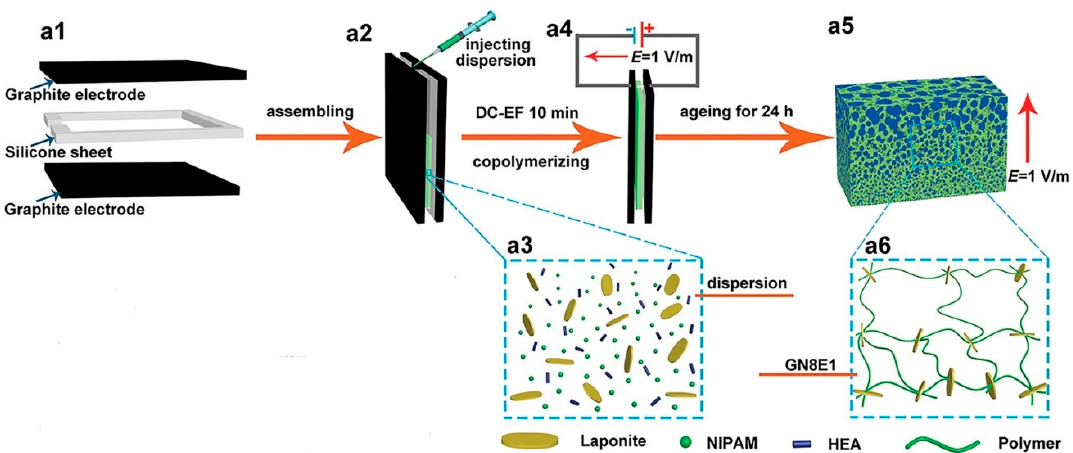
Figure 2. Scheme of synthesis of the bionic gradient hydrogel ( a1 – a4 ), polymerization dispersion ( a5 ), and gradient network structure ( a6 ). Reprinted from [7] with permission.